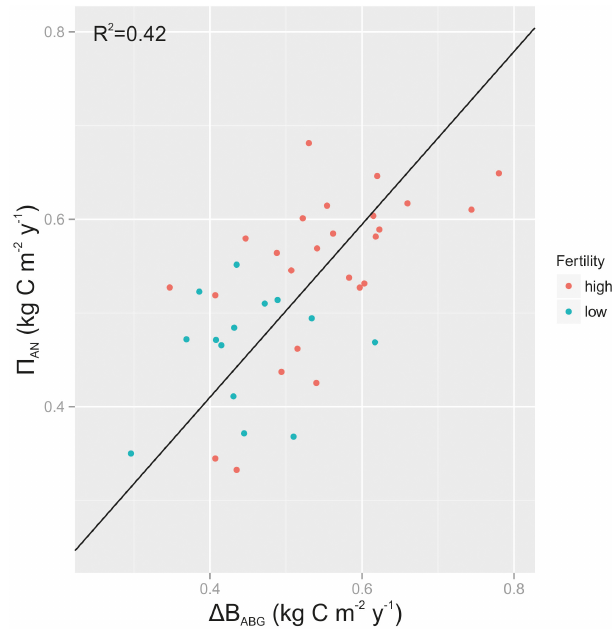
Figure 5. Simulated stand-level aboveground net primary produc- tivity ( 5 AN ) against observed stand-level aboveground biomass growth ( 1B ABG ) of surviving trees, at the 40 PM plots. The line illustrates a SMA regression of α = 0 . 92 ( 0 . 72 ,..., 1 . 18) and R 2 = 0.42. Red dots indicate high nutrient availability and blue dots indi- cate low nutrient availability